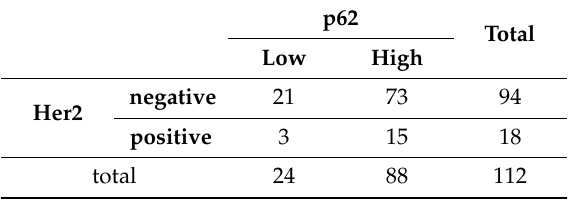
Table 2. Results of the p62 scoring in correlation with the Her2